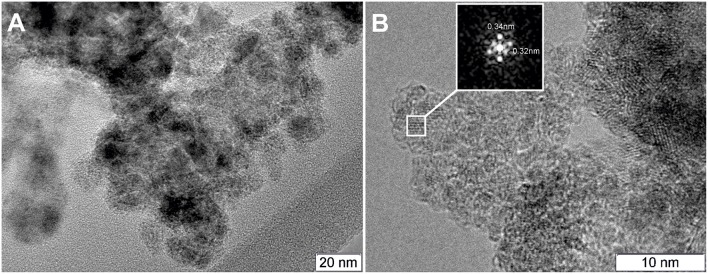
TEM image of the PtCeC composite (A) and Fourier image of the crystal lattice of a nanoparticle (B).